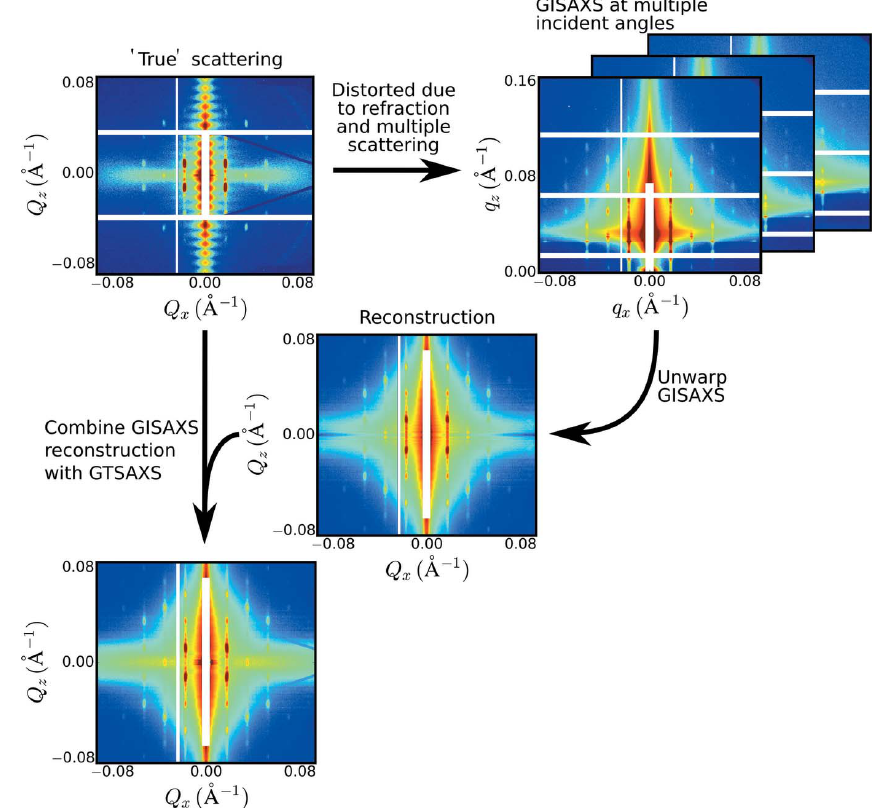
Figure 1 In GISAXS, the sample’s ‘true’ scattering is distorted because of refraction of incident and scattered rays, and multiple scattering effects, which lead to superimposed scattering features and non- monotonic modulation of intensities. These effects greatly complicate the analysis of GISAXS data. Here, we present a method to combine multiple GISAXS images measured at different incident angles, thereby reconstructing a faithful estimate of the unwarped reciprocal-space scattering. This reconstruction can be combined with grazing-transmission measurements (GTSAXS) if available, to further improve data quality. Example data shown in the figure were collected in GISAXS and GTSAXS geometry on a thin film of shear-aligned block copolymer. The reconstruction is difficult to ’ 0 because of the beamstop. However, the structural peaks resolved elsewhere assess near Q x demonstrate the quality of the